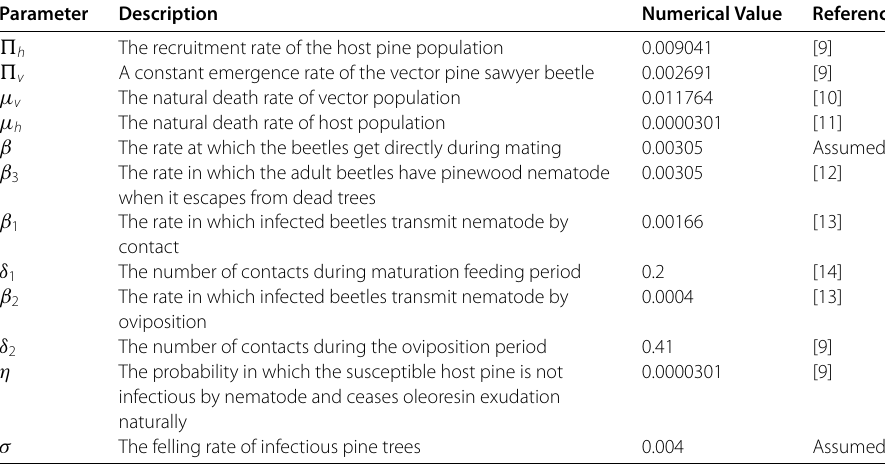
Table 2 Sensitivity indices of R 0 , I ∗ Parameter